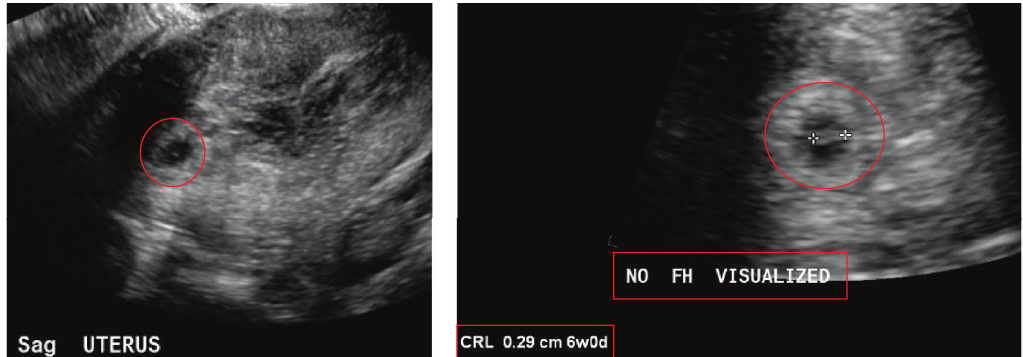
Figure 3: Patient number 2. Obstetric ultrasound on 3/2/2014: intrauterine gestational sac seen. There is adjacent heterogeneity suggesting subchorionic hemorrhage. No fetal cardiac activity detected. Fetal pole measures approximately 2.9 mm.